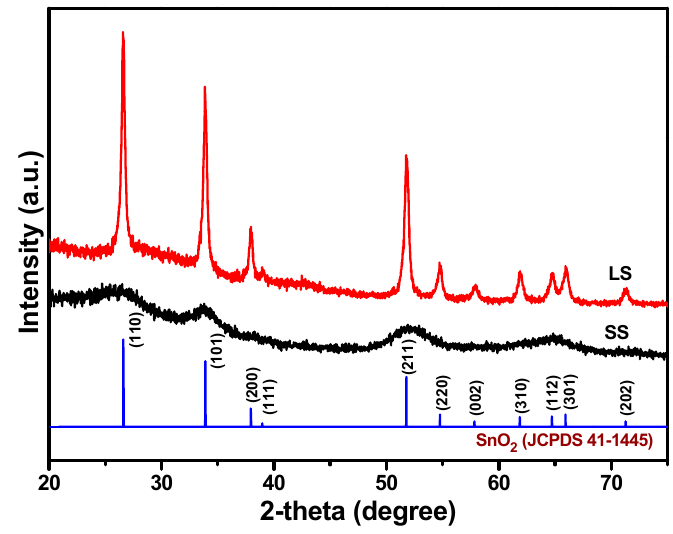
Figure 1. XRD patterns of the small size (SS) and large size (LS) SnO 2 nanoparticles.